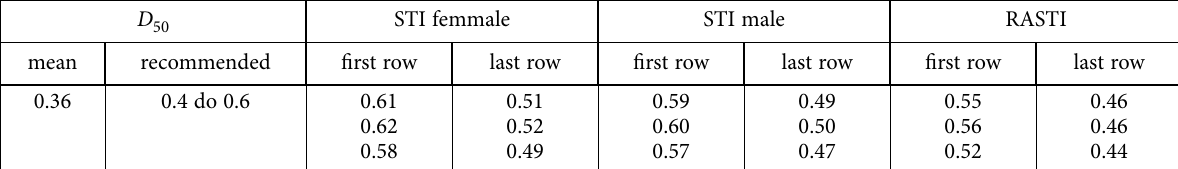
Table 9. Values of acoustic parameters D 50 , STI and RASTI obtained in the simulation after acoustic